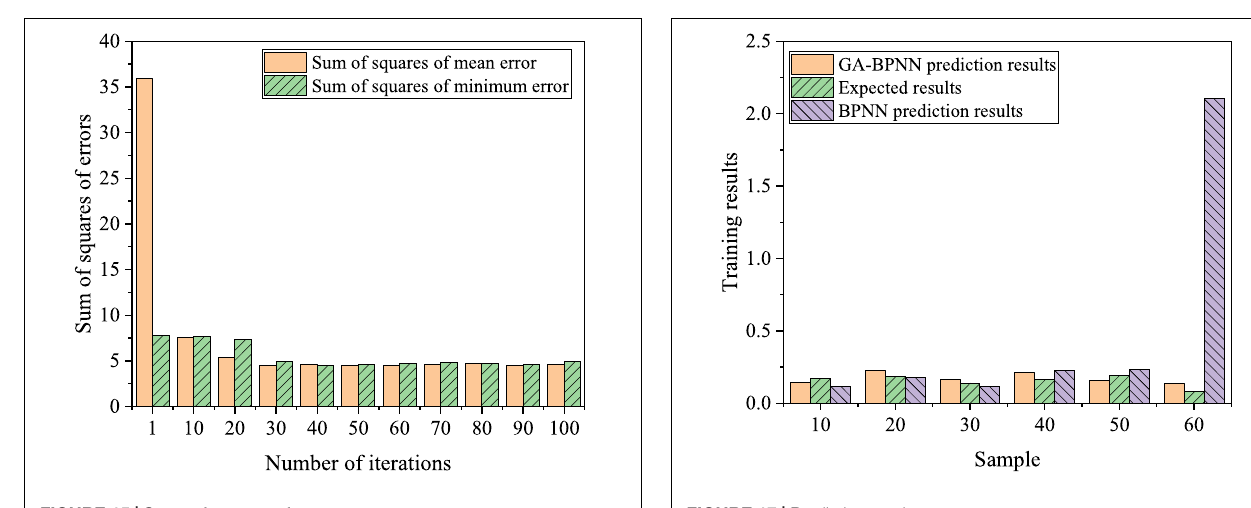
FIGURE 17 | Prediction